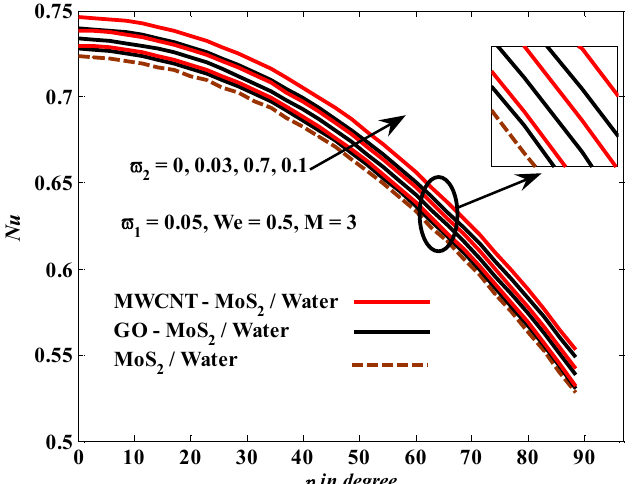
Figure 8. The behavior of hybrid nanofluid’s Nusselt number under the effect of ultrafine particle volume fraction.